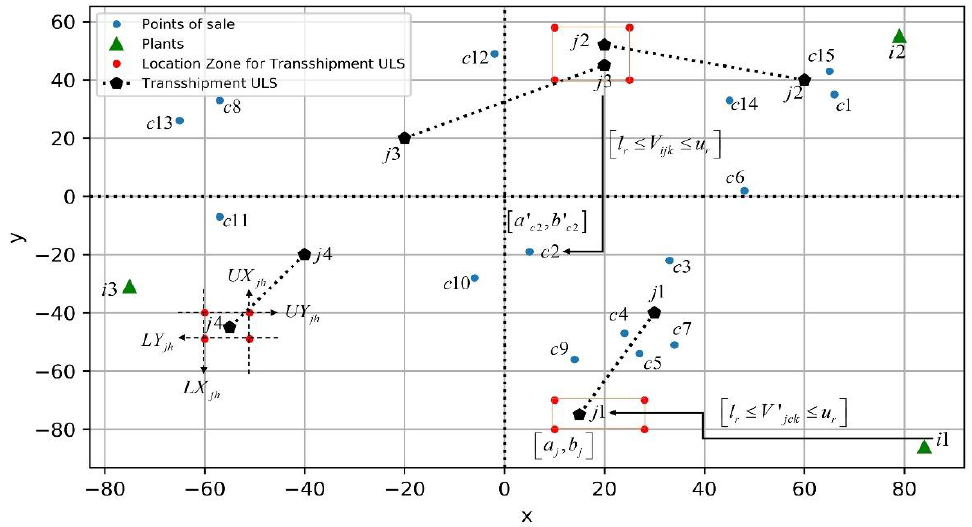
Figure 4. Representation of the conceptual model.